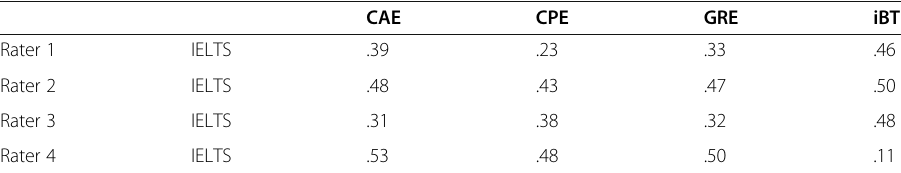
Table 2 Inter-item correlation matrix